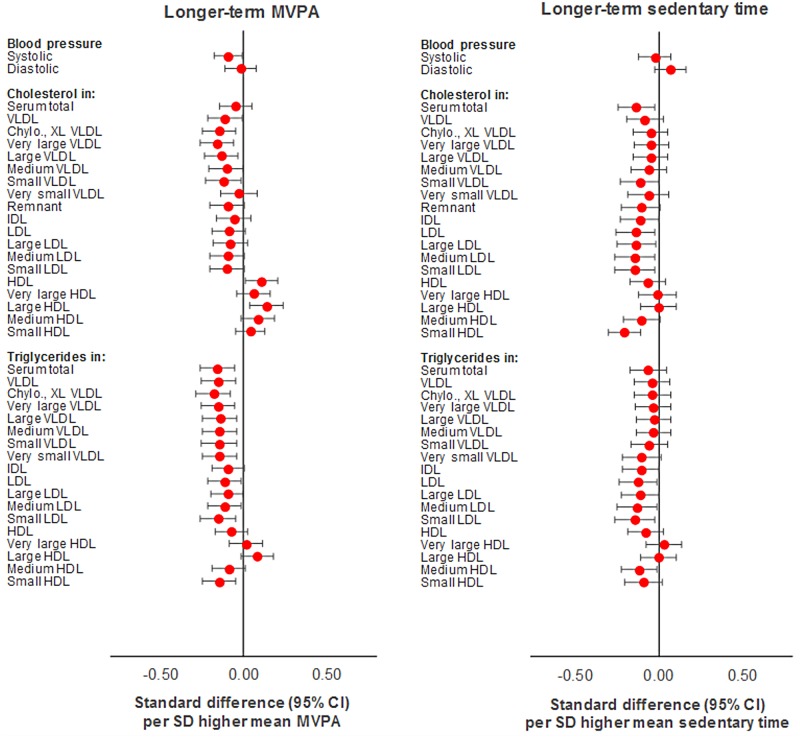
Mutually adjusted associations of longer-term MVPA and sedentary time with blood pressure, cholesterol, and triglycerides at age 15y in ALSPAC.Metabolic traits are in standardised units. Longer-term MVPA/sedentary time defined as mean of 3 measures (at age 12y, 14y, and 15y). Models are adjusted for age, sex, ethnicity, maternal education, device wear time and wear month, alternative measure (MVPA or sedentary time) based on mean across 3 measures, and fat mass index based on mean across 3 measures. ALSPAC, Avon Longitudinal Study of Parents and Children; MVPA, moderate-to-vigorous physical activity.